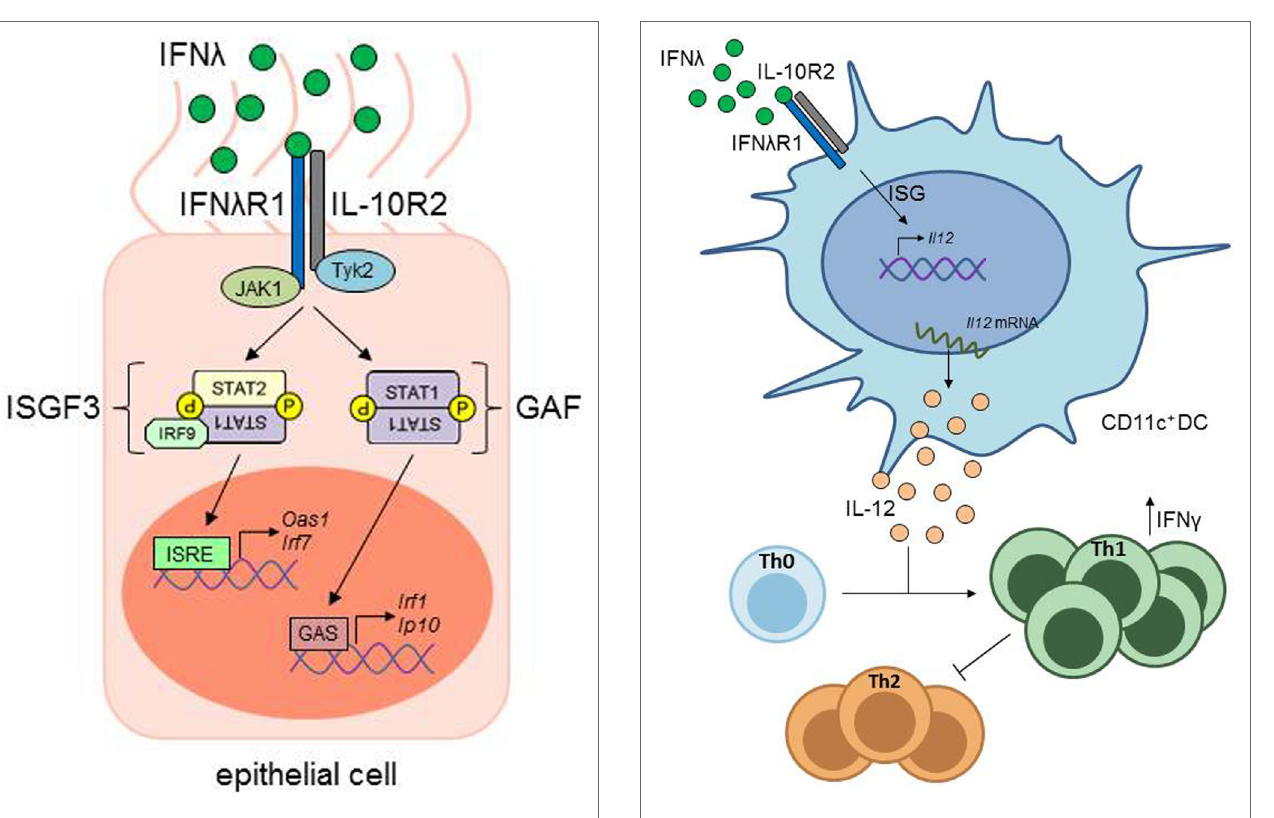
FiGURe 2 | IFN- λ signaling in epithelial cells. IFN- λ binds to its IFN λ R1, which leads to a conformational change and the recruitment of the IL-10R2 chain. Receptor-associated kinases (JAK1, Janus kinase 1; Tyk2, tyrosine kinase 2) trans-phosphorylate the respective receptor chains, leading to the phosphorylation and activation of signal transducer and activator of transcription (STAT) proteins. STAT1 and STAT2, together with IFN-regulatory factor 9 (IRF9), build the IFN-stimulated gene factor 3 (ISGF3) transcription factor complex, while the STAT1 homodimer is also named gamma-IFN activated factor (GAF). ISGF3 and GAF complexes are able to translocate to the nucleus and bind to IFN-stimulated response elements (ISRE) or gamma-IFN activation sites (GAS), respectively, in the promoter regions of IFN-stimulated genes (ISG), e.g., Oas1 , Irf1 , Irf7 , or Ip10 [adapted from Ref. (61)]. ISG, interferon-stimulated